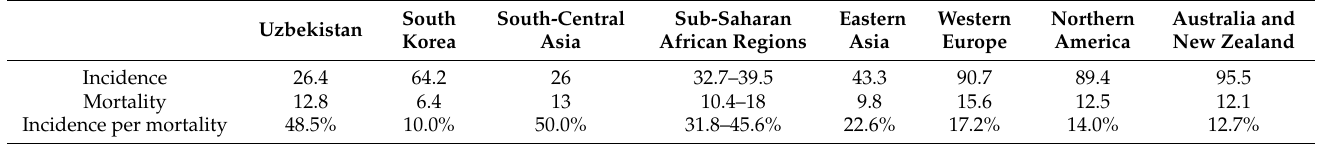
Table 2. Brief global statics of breast cancer, including Uzbekistan and South